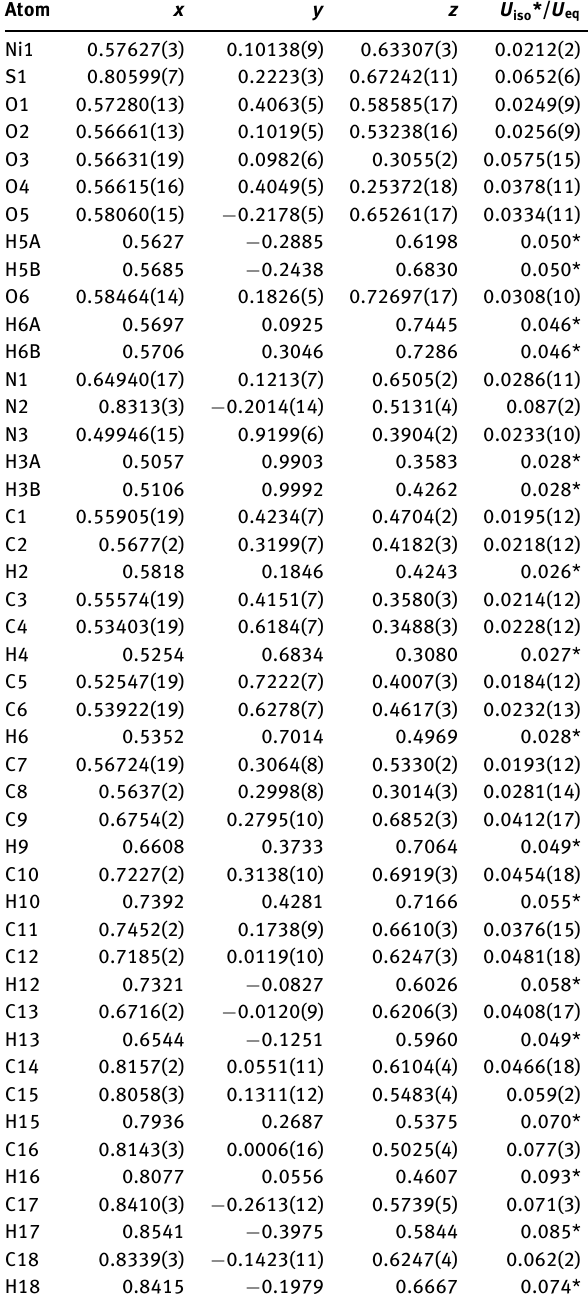
Table 2: Fractional atomic coordinates and isotropic or equivalent isotropic displacement parameters (Å 2